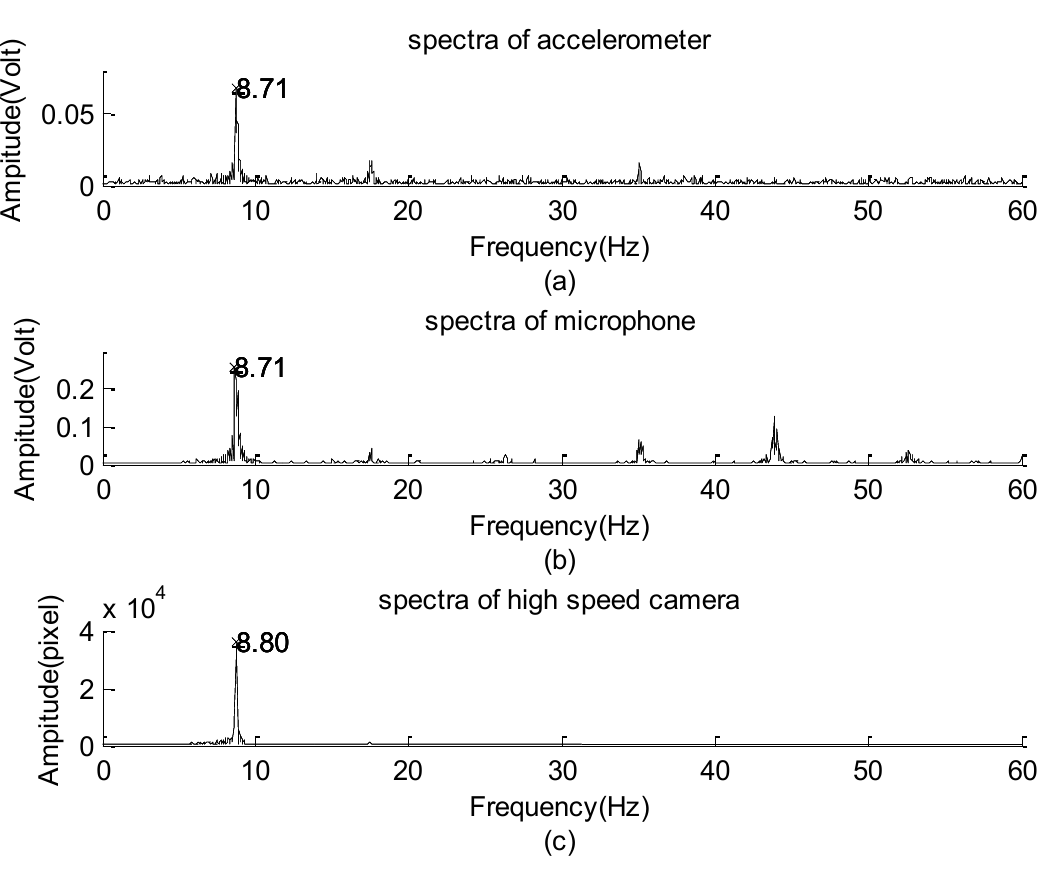
Figure 15. Spectra of the small helicopter in operation captured by: ( a ) accelerometer. ( b ) microphone. ( c ) high speed camera.